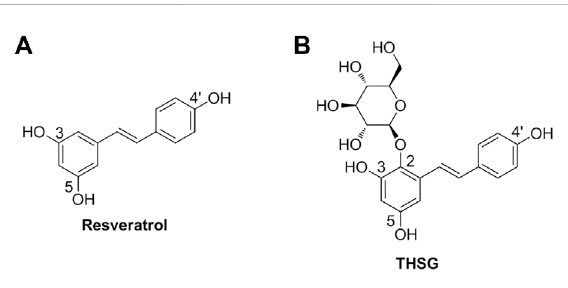
FIGURE 1 (A) The chemical structure of resveratrol (3,5,4 ′ -trihydroxy- trans -stilbene). (B) The chemical structure of resveratrol glycosylated derivative (2,3,5,4 ′ -tetrahydroxystilbene-2- O - β -D- glucoside;